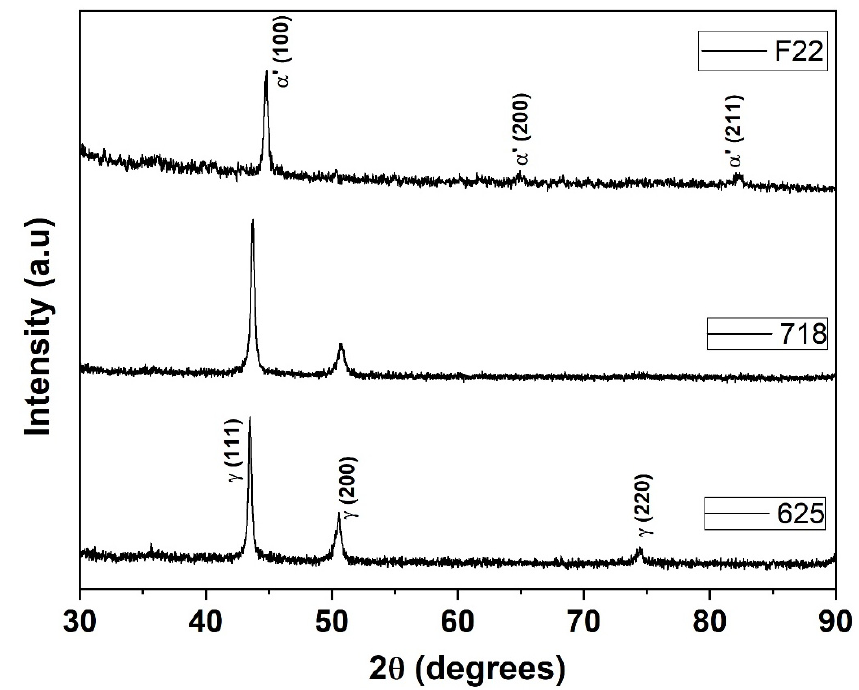
Figure 3. XRD diffraction patterns of the alloy F22, 718, and 625 base metals.